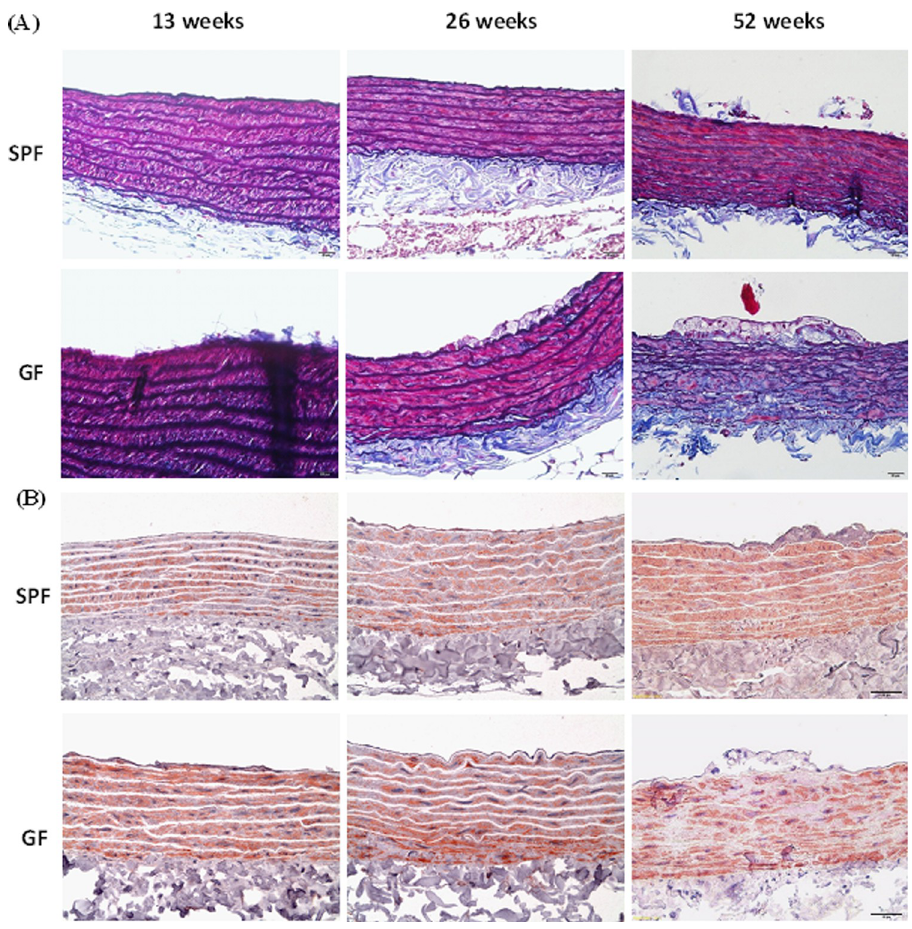
Fig 4. Histopathology and immunohistochemical staining of thoracic aorta lesions. (A) Elastic fiber (Elastica– Masson’s trichrome) stain, and (B) α -smooth muscle actin stain. GF: germ free, SPF: specific pathogen free.